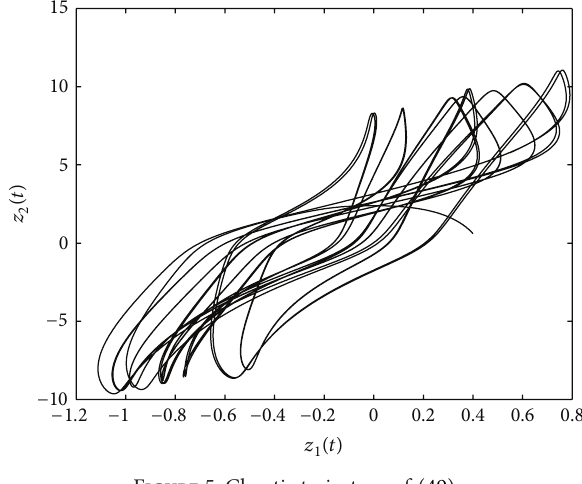
Figure 5: Chaotic trajectory of (49).